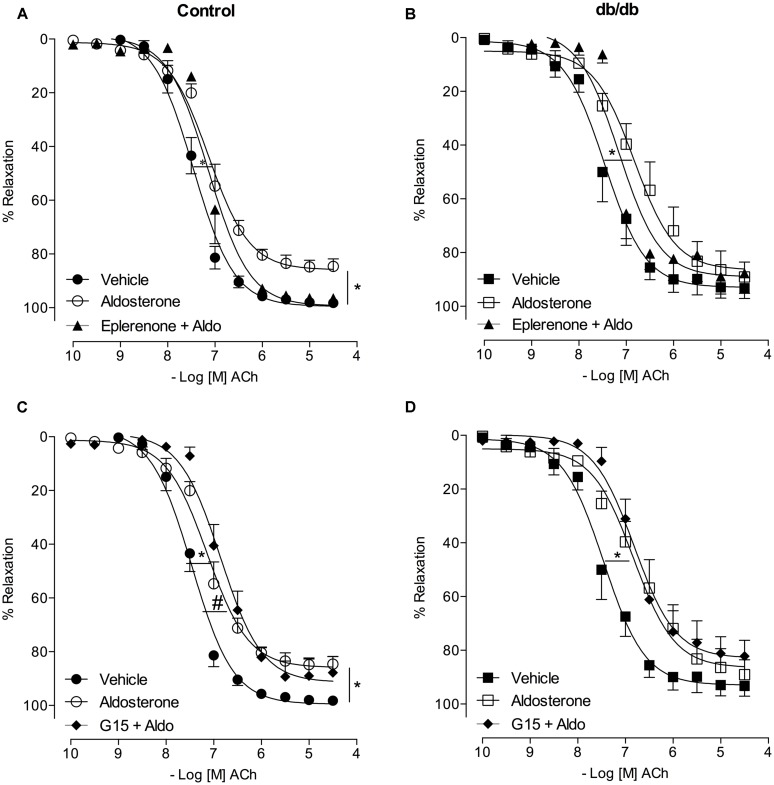
Aldosterone decreases ACh-induced relaxation in control and db/db mice by mechanisms dependent on MR activation. The figures show concentration-response curves to ACh in the presence of aldosterone (10 nM) in MA from control (A,C) and diabetic (B,D) mice. Effects of eplerenone (10 μM; A,B) or G15 (1 μM; C,D) on ACh-induced relaxation in the presence of aldosterone. Data represent the mean ± SEM of the values relaxation (% of PhE-induced precontraction). (n = 4–7 per group). One-way ANOVA with Bonferroni post-test (*), (#; p < 0.05) vs. vehicle and aldosterone, respectively.